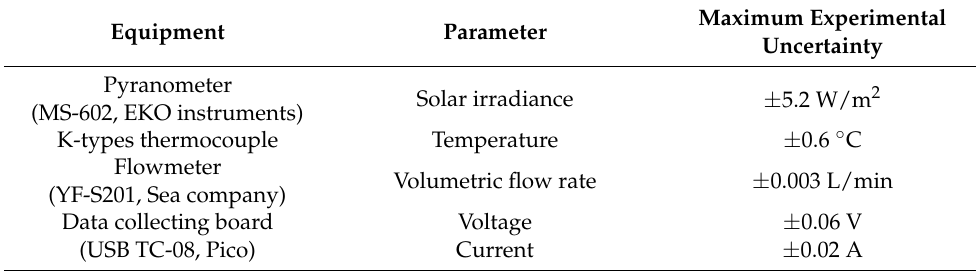
Table 1. Experimental uncertainty values of the measurement instruments